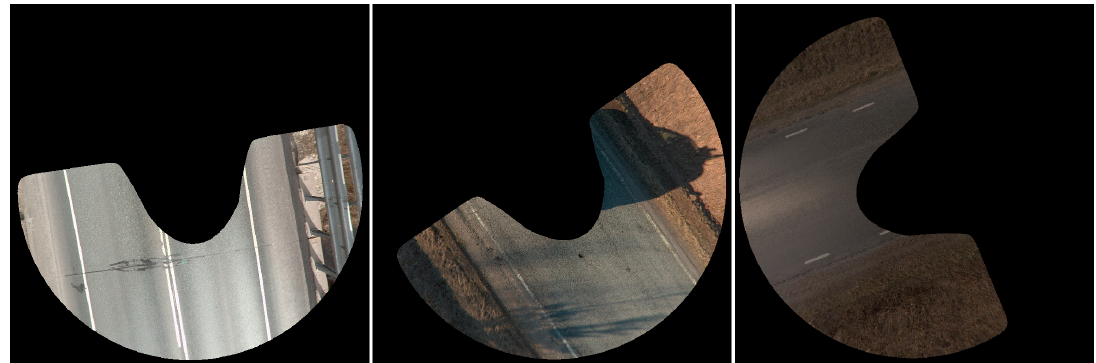
Figure 1. The orthoframes depicting the road.